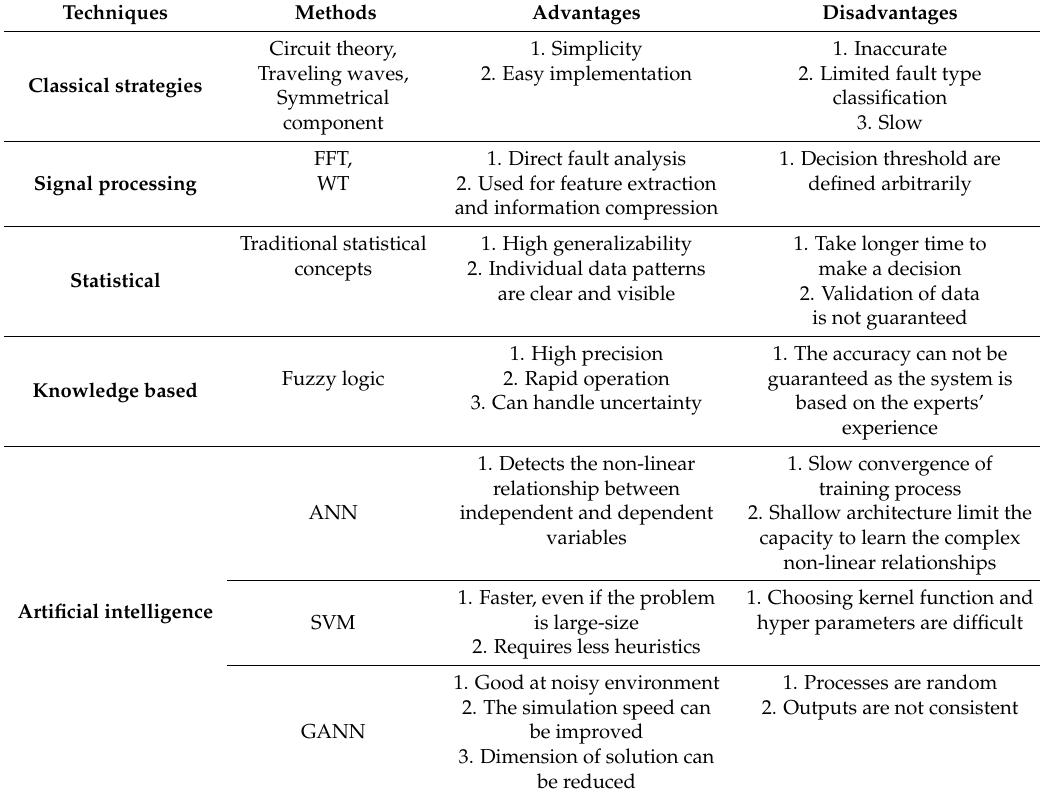
Table 6. Comparison of the advantages between the existing and the proposed FDC